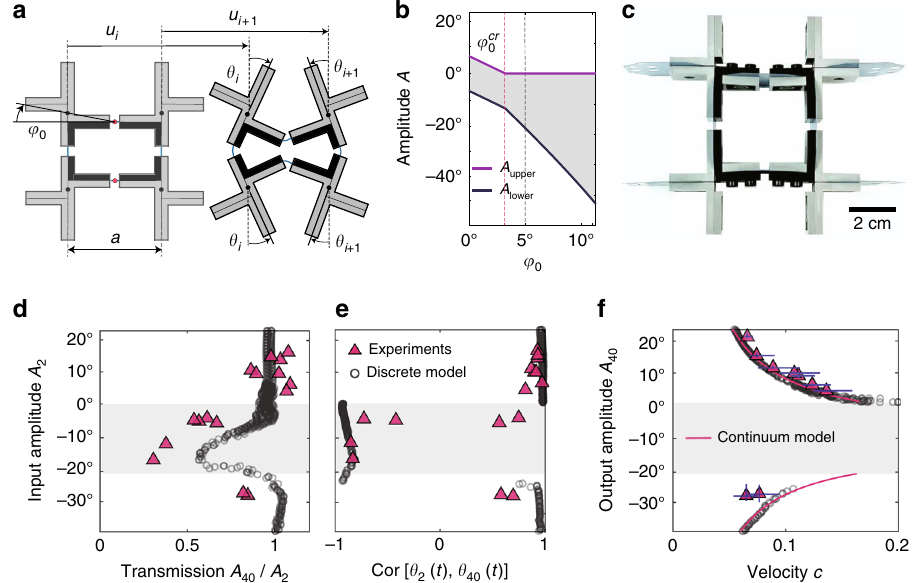
Fig. 2 Propagation of elastic vector solitons in a chain with vertically shifted neighboring horizontal hinges. a Schematic of the system. Neighboring horizontal hinges are shifted by a tan φ 0 in vertical direction. b Evolution of the amplitude gap as a function of the angle φ 0 . c Few units of our sample characterized by φ 0 = 5° (Scale bar: 2 cm). d Measured transmission, A 40 / A 2 , as a function of the amplitude of the input signal, A 2 . e Measured cross- correlation of θ 2 ( t ) and θ 40 ( t ) as a function of the amplitude of the input signal, A 2 . f Evolution of the pulse velocity c as a function of its amplitude. The gray region in b and d – f highlights the amplitude gap as predicted by the continuum model. The error bars in f show the 95% con fi dent interval of the measured velocities and amplitudes of solitons in experiments. The corresponding error bars for simulation results are too small to